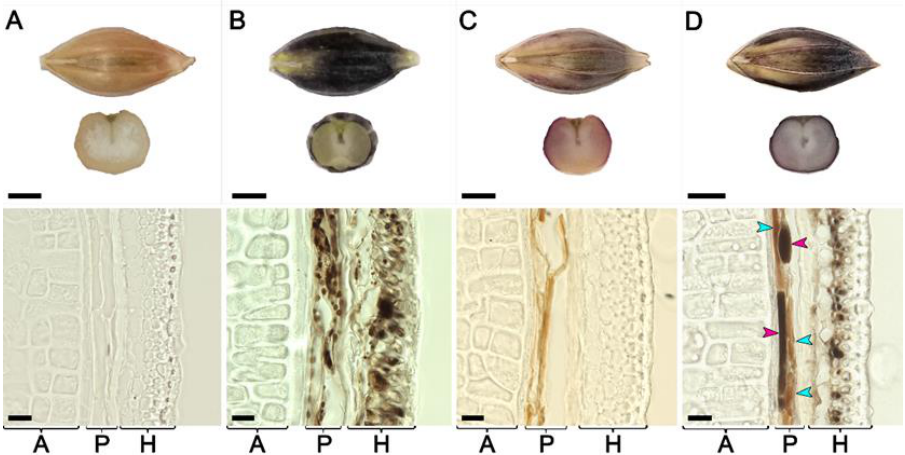
Figure 3. Seeds and cross-sections of the seeds produced by cv. Bowman ( A ) and lines BLP ( B ), PLP ( C ), and BP ( D ) sampled at the hard dough stage. A: aleurone layer, H: husk, P: pericarp. Turquoise arrowheads point to brownish-red rod-shaped structures, and magenta arrowheads indicate brownish-black rod-shaped structures. Scale bars for the seeds are 2.5 mm, and for the micrographs, 20 µm.